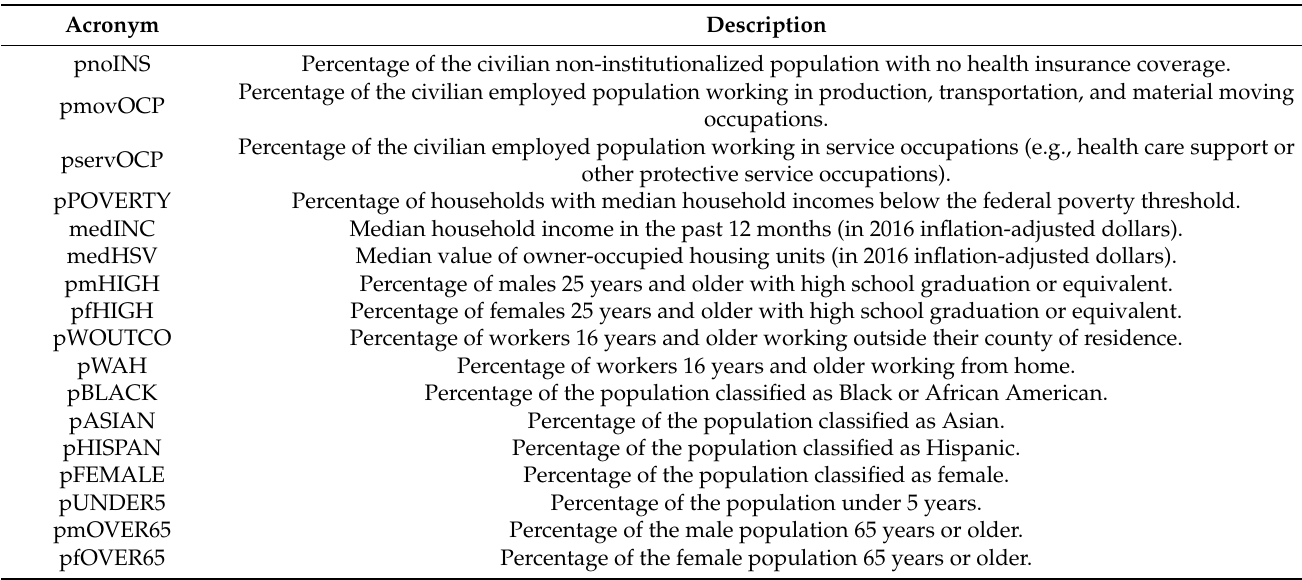
Table 1. Social, economic, and demographic variables selected from the 2014–2018 American Community